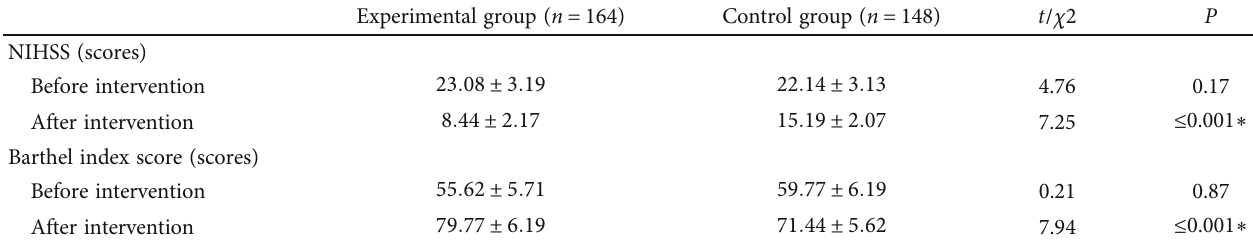
Table 2: Comparison of NIHSS and Barthel index score between the two groups before and after intervention ( (cid:1) x ± s ). Experimental group ( n = 164 )